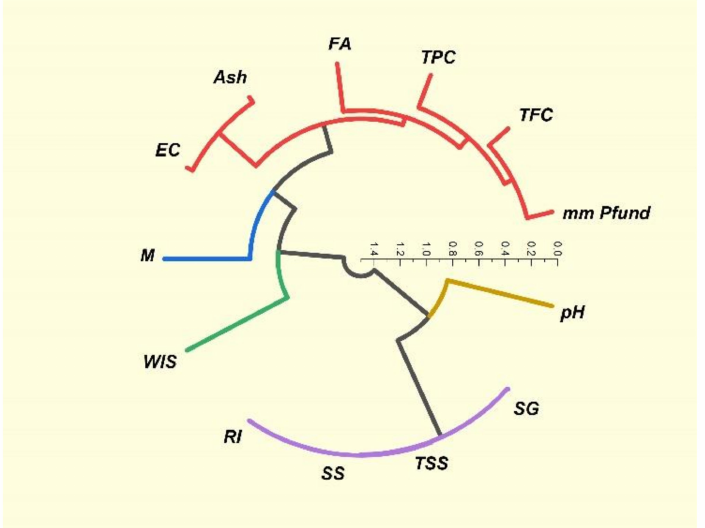
Figure 7. Circular hierarchical cluster analysis (HCA) of studied honey sample